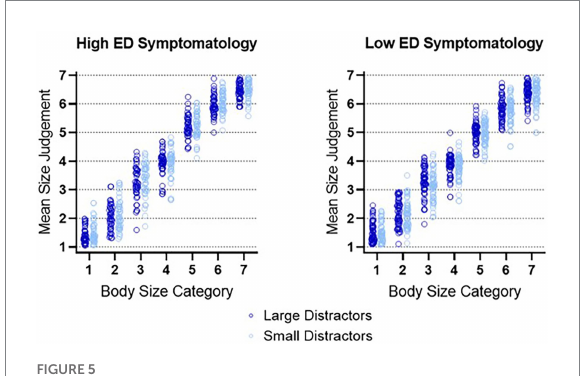
FIGURE 5 Mean individual ratings for each body size category for all participants. Created using GraphPad